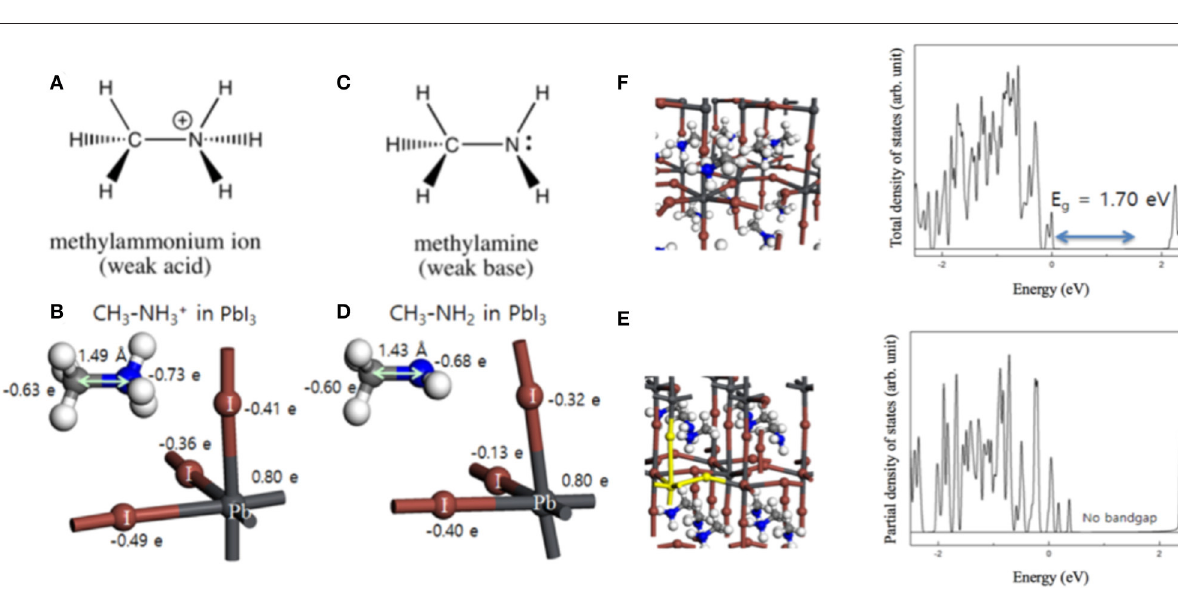
FIGURE 10 | Electron configurations in (A,B) CH 3 NH + 3 cation and (C,D) CH 3 NH 2 molecule in perovskite structure. The perovskite structure is distorted with CH 3 NH 2 neutral molecule. The DOS calculation for the bandgap of (F) CH 3 NH 3 PbI 3 and (E) CH 3 NH 2 PbI 3 . The CH 3 NH 2 PbI 3 has no bandgap. [Reprinted with permission from Jung et al.